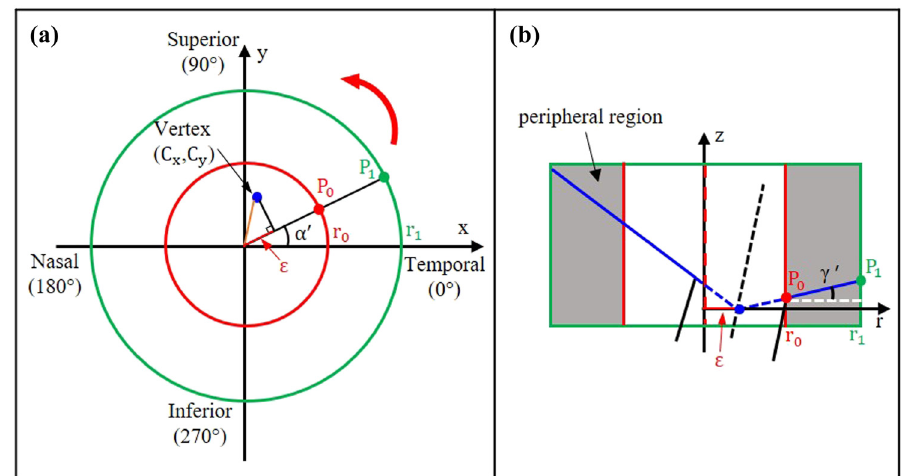
Figure 4: The fundus view ( a ) and a cross - sectional view ( b ) of the optic disc. ( a ) The red circle marked the inner boundary of the ppRPE/BM layer in the OCT scan, and the green circle marked the outer boundary. The distance of the surface vertex C C , x y ( ) to the origin of the X – Y coordinates ( axis of scanning beam ) was highlighted in orange. The eccentricity ( ε ) at the radial angle of α ′ was highlighted in red. ( b ) The cross - sectional view of the ppRPE/BM layer at a radial angle of α ′ , and the peripheral region of the optic disc was highlighted in gray color. P 0 and P 1 are the inner point and outer point of the ppRPE/BM layer,